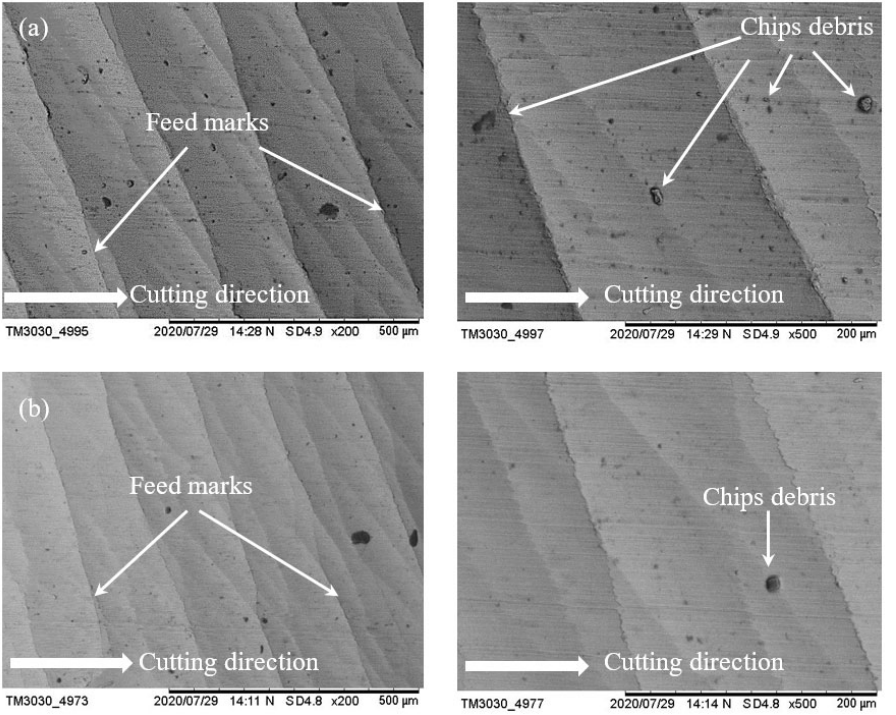
Figure 7. SEM micrographs of surface morphology at parametric combinations of n = 17,100 rpm, f = 400 mm/min and P = 700 mW; ( a ) conventional cutting fluid and ( b ) water-soluble sago starch cutting fluid.